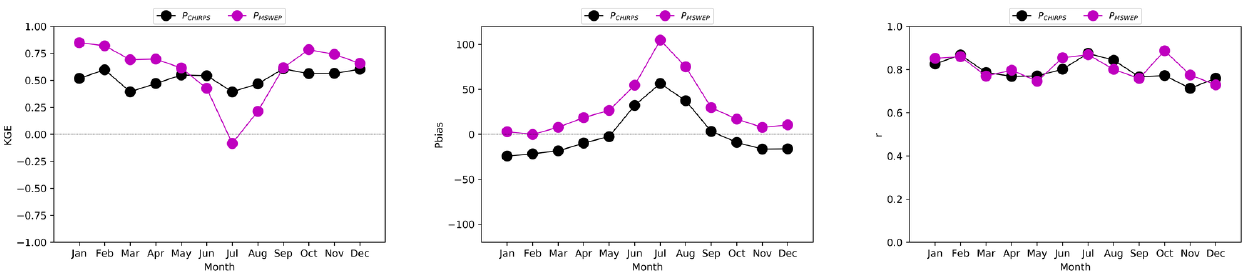
Figure 3. KGE, P bias and r performance metric for monthly CHIRPS and MSWEP precipitation in the Coello basin for 30 years (1983–